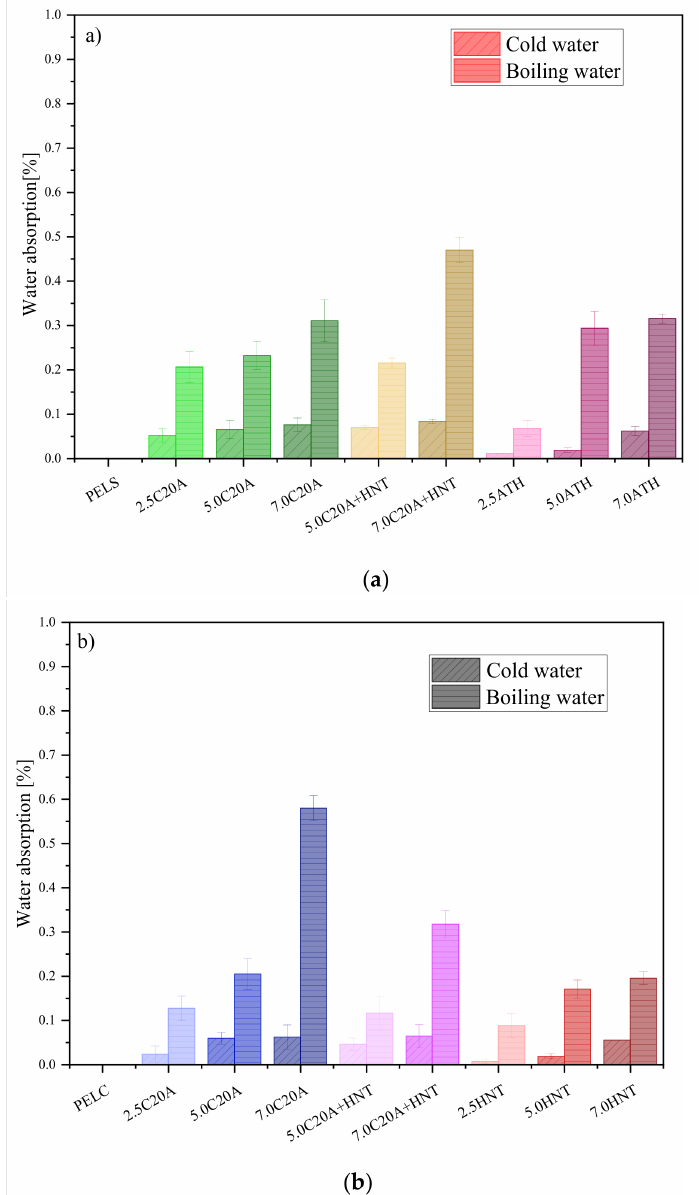
Figure 11. Cold and hot water absorption: ( a ) PELS-based nanocomposites; ( b ) PELC-based